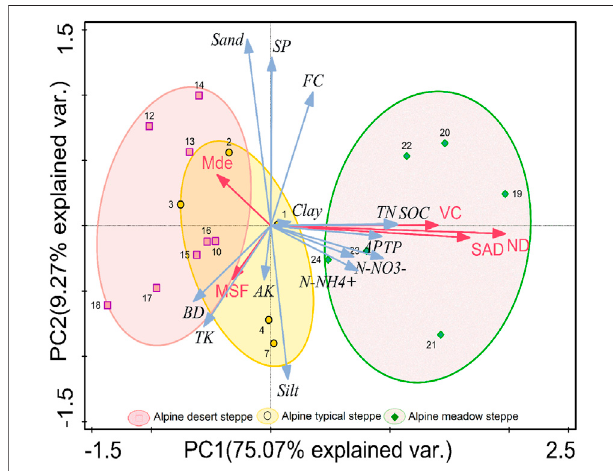
FIGURE 4 | Results of PCA analysis, which shows the relationship between the rock fragment characteristics and the soil variables. The red arrows indicate rock fragment parameters; the blue arrows indicate soil physiochemical